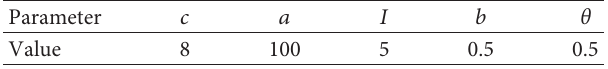
Table 3: Parameters and